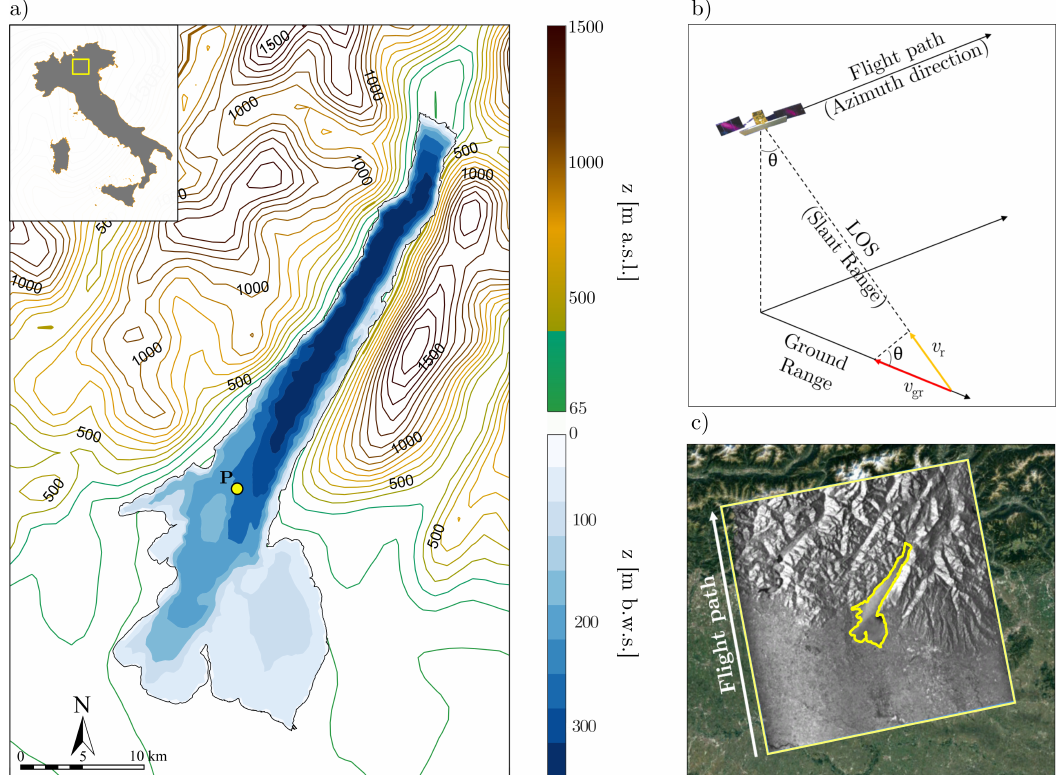
Figure 1. ( a ) Location of Lake Garda in northern Italy; orography of the surrounding area in m above sea level (m a.s.l.); lake bathymetry in m below water surface (m b.w.s.). ( b ) Scheme of the SAR acquisition geometry. ( c ) Example of an amplitude focused SAR image of an ENVISAT acquisition centered on lake. The SAR image is geocoded and superimposed on the corresponding Google Earth